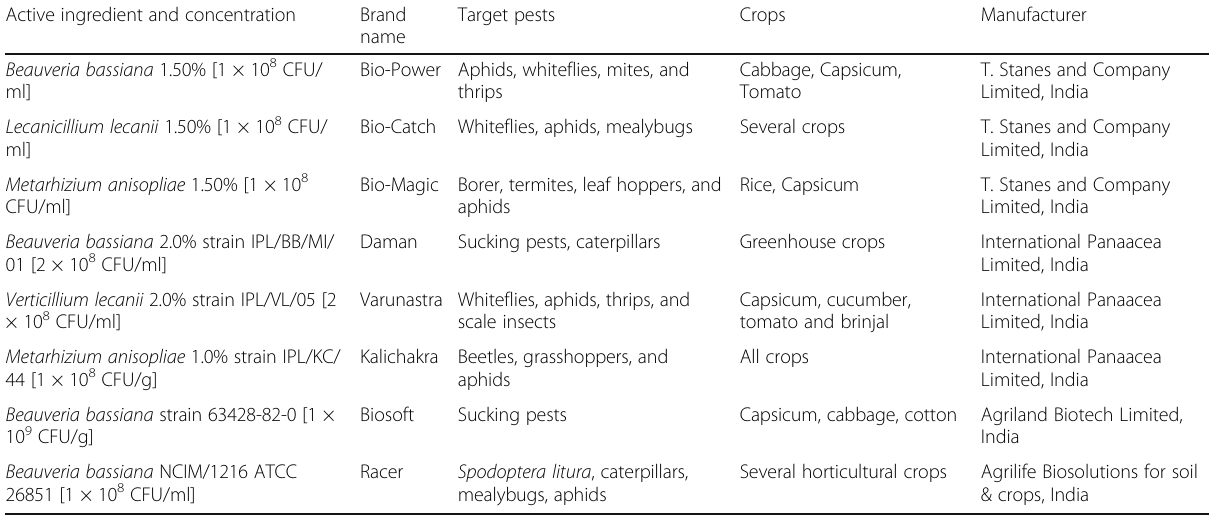
Table 2 Commercial bioformulations for the management of aphid and whitefly species under protected conditions in India Active ingredient and concentration Brand Target pests Crops name